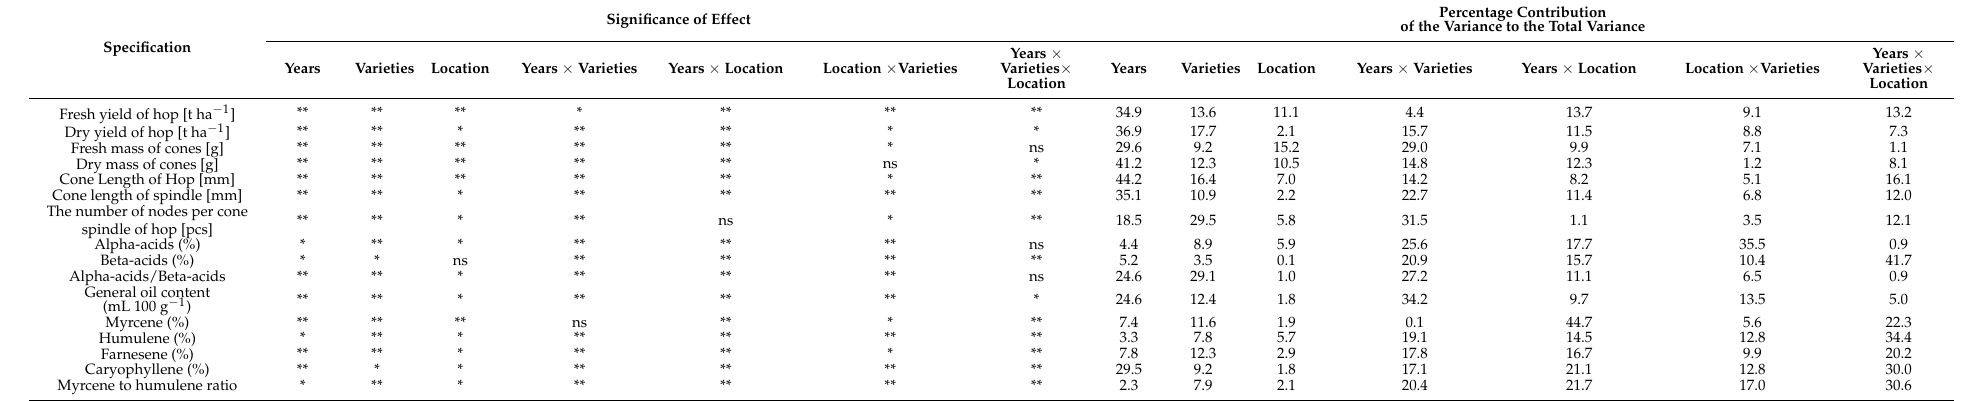
Table 17. Effect of cultivars, locality, and years on the chemical composition of H. lupulus and their percent contribution to the total